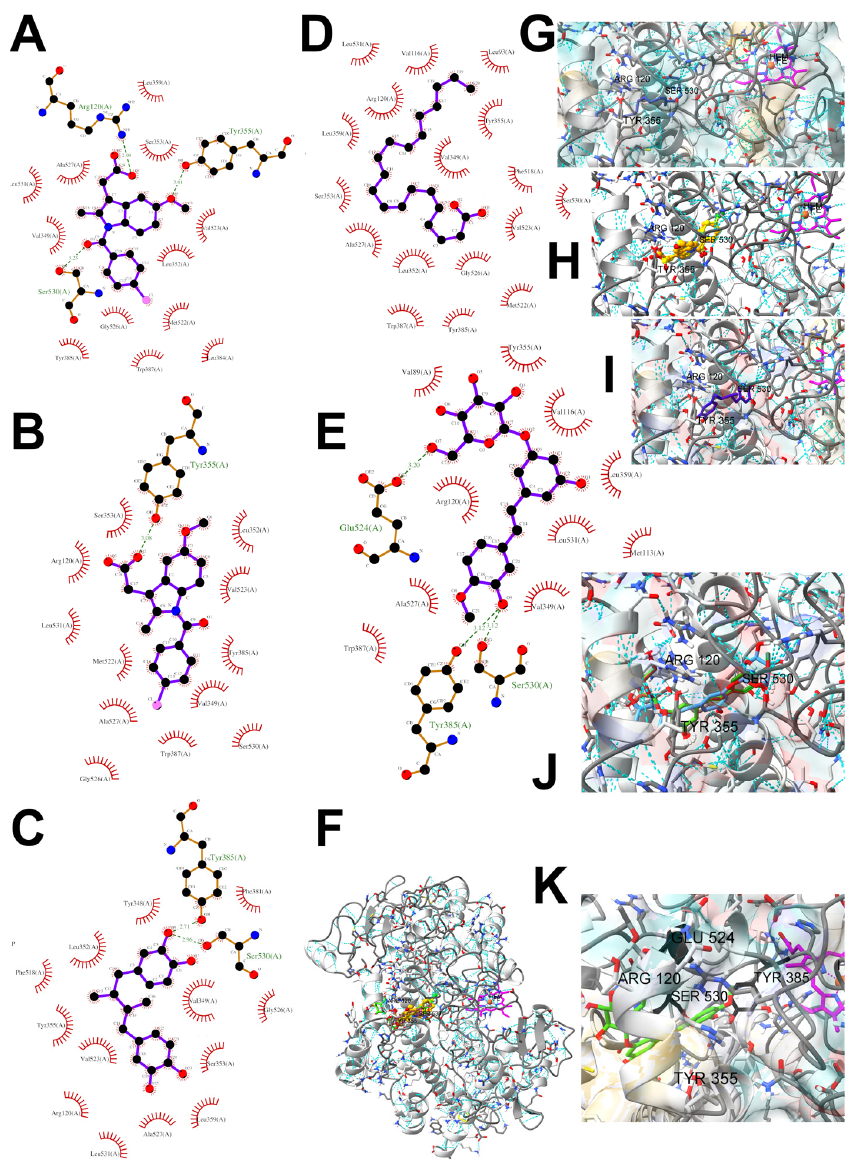
Figure 8. Ligand binding analysis in the area of hydrophobic COX-2 active site pocket 1 according to the crystal structure 4COX where the location of indomethacin was determined experimentally. The panels from A to F are LigPlot+ v.2.2 analysis: ( A ) experimental indomethacin binding with amino acid residues in the 4COX crystal structure, ( B ) docking studies of indomethacin, ( C ) NDGA docking, ( D ) arachidonate docking ( E ) rhaponticin docking. The panels from F to K show the spatial structure of the COX-2 monomer. ( F ) A view of the whole monomer-bound indomethacin molecules